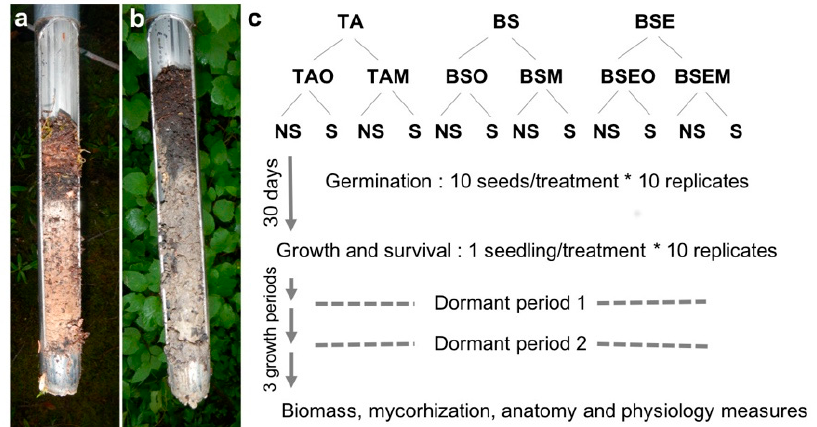
Figure 1. Soil cores from black spruce (BS) ( a ) and trembling aspen (TA) ( b ) stands showing the difference between organic and mineral soil layers, and ( c ) experimental scheme showing the 12 different treatments and three growth seasons : TAO (Trembling aspen organic layer), TAM (Trembling aspen mineral layer), BSO (Black spruce organic layer), BSM (Black spruce mineral layer), BSEO (Black spruce and Ericaceae, organic layer), BSEM (Black spruce and Ericaceae, mineral layer), NS (non sterile treatment, and S (sterile treatment)).